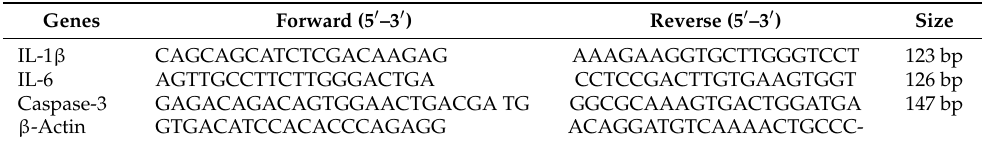
Table 2. The primer sequences used in the present